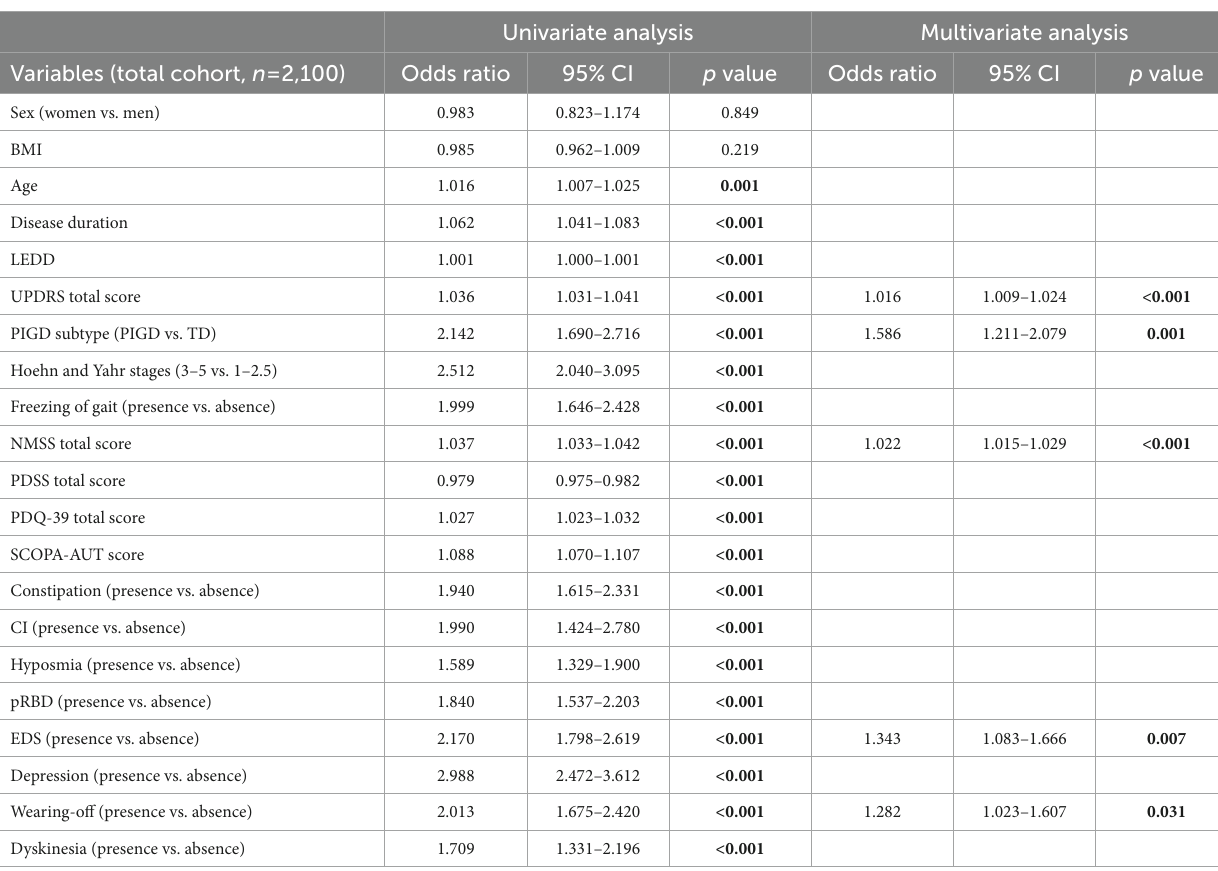
TABLE 2 Factors Associated with Fatigue in PD.